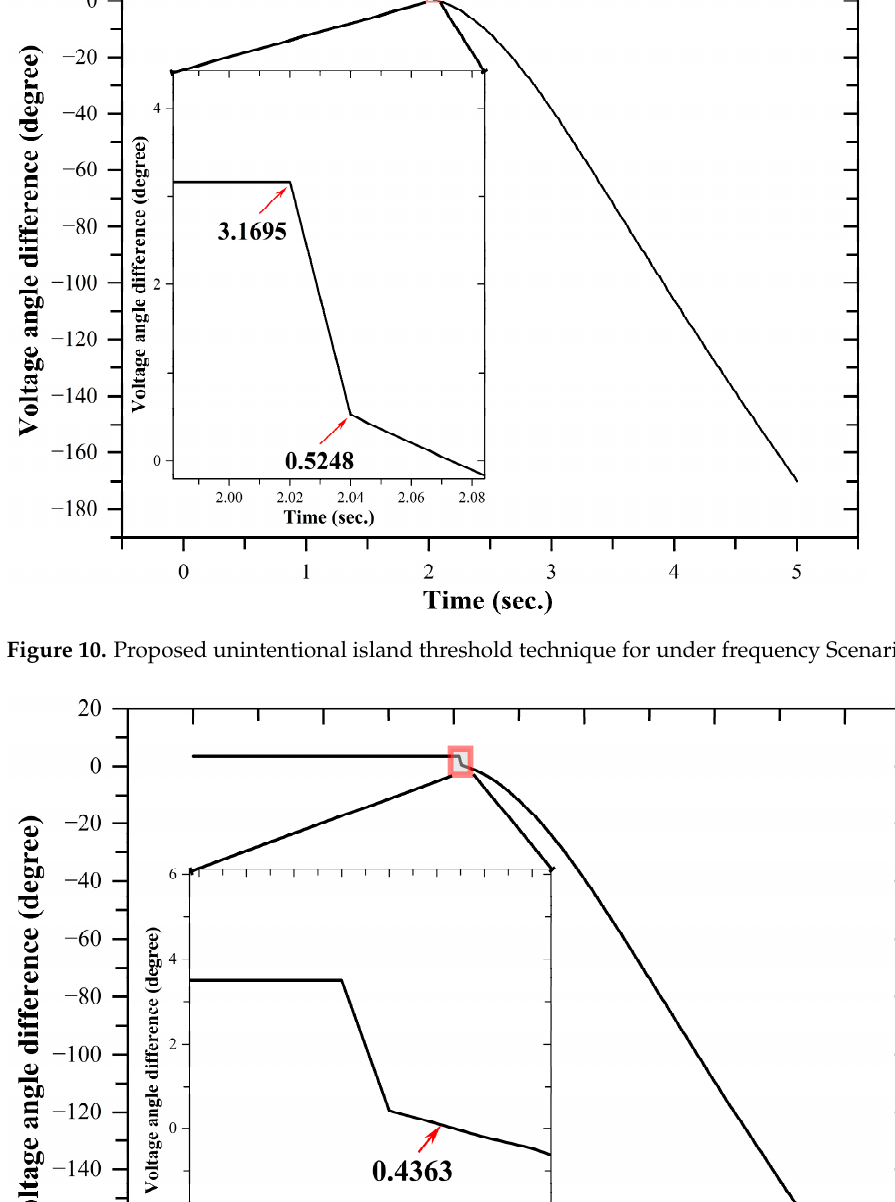
Figure 9. Proposed unintentional island threshold technique for under frequency Scenario 1.